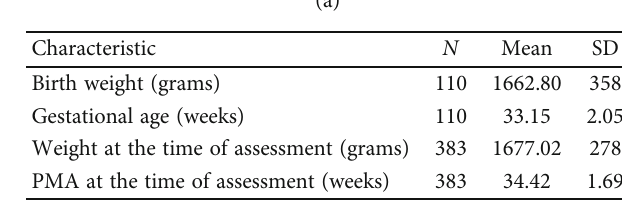
Table 1: Baseline